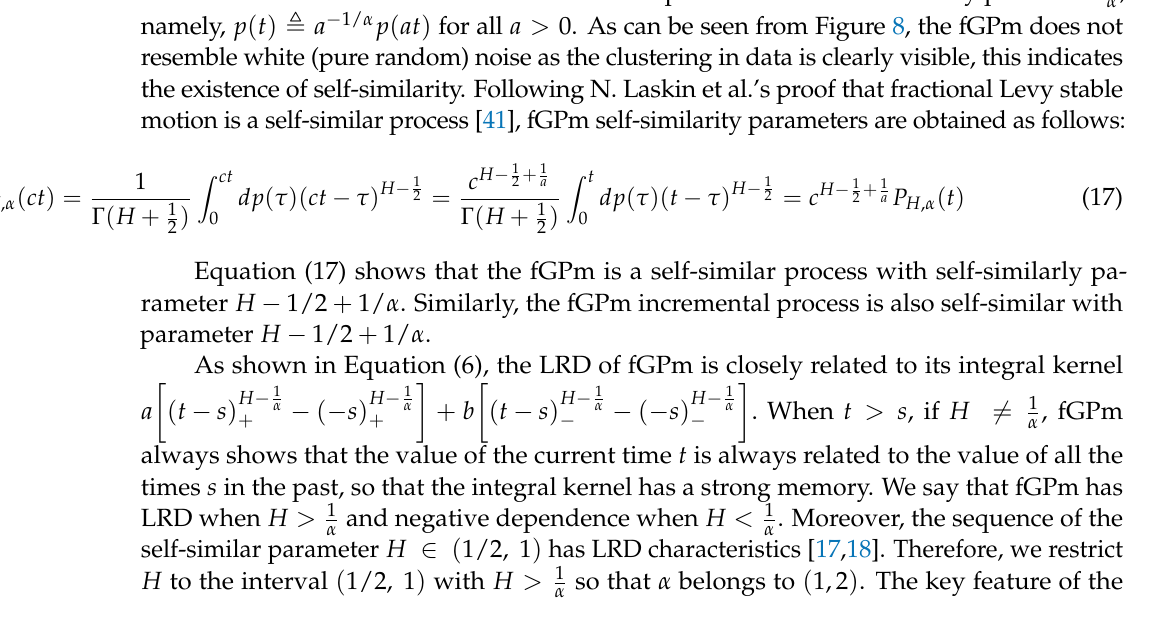
Figure 9. fGPm increment data generated with different α = 2, 1.75 , 1.5 , 1.25, respectively, H = 0.75 .